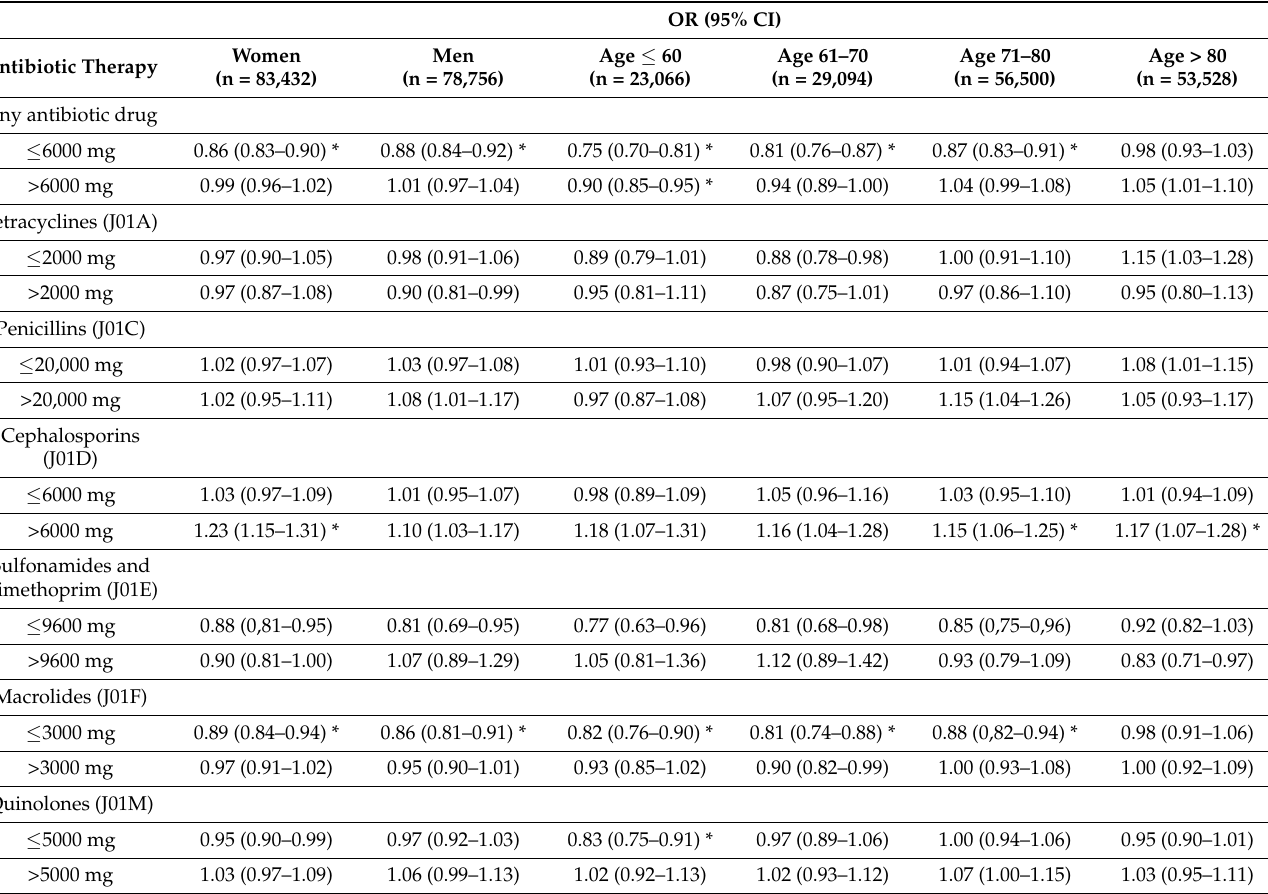
Table 3. Association between antibiotic therapy and heart failure by sex and age groups (multivariable logistic regression